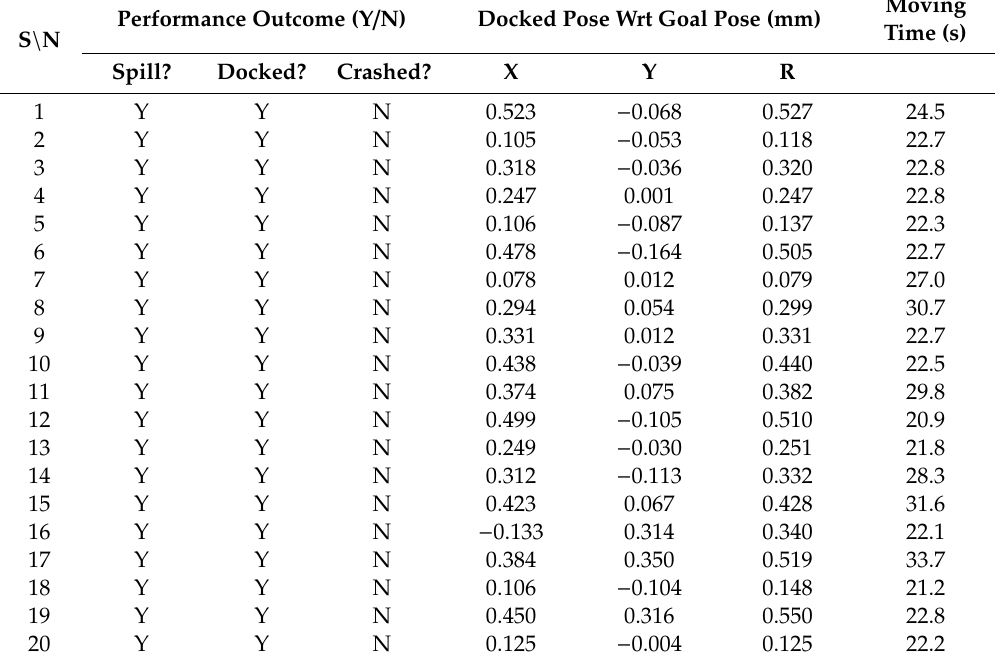
Table 2. Performance result of MoveBase control.